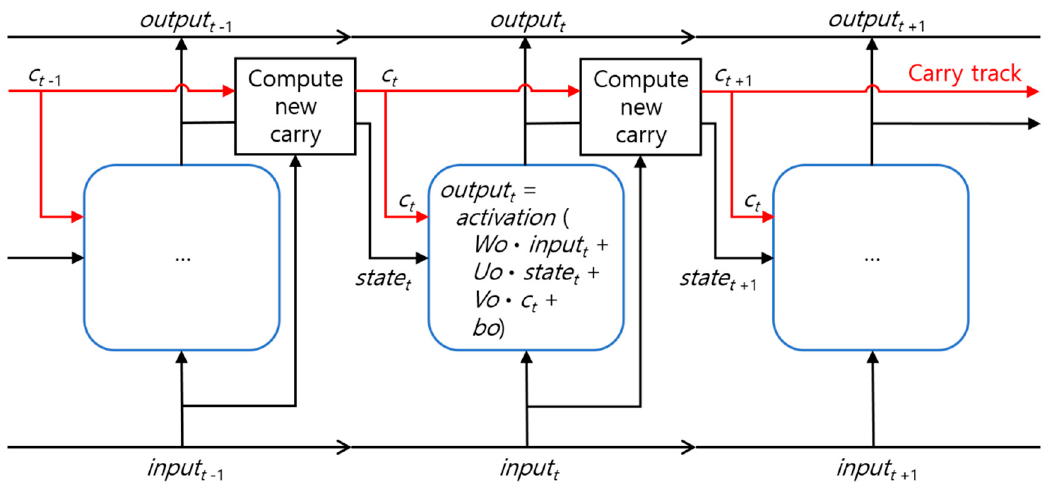
Figure 4. LSTM architecture. Reproduced from Chollet and Allaire [26].